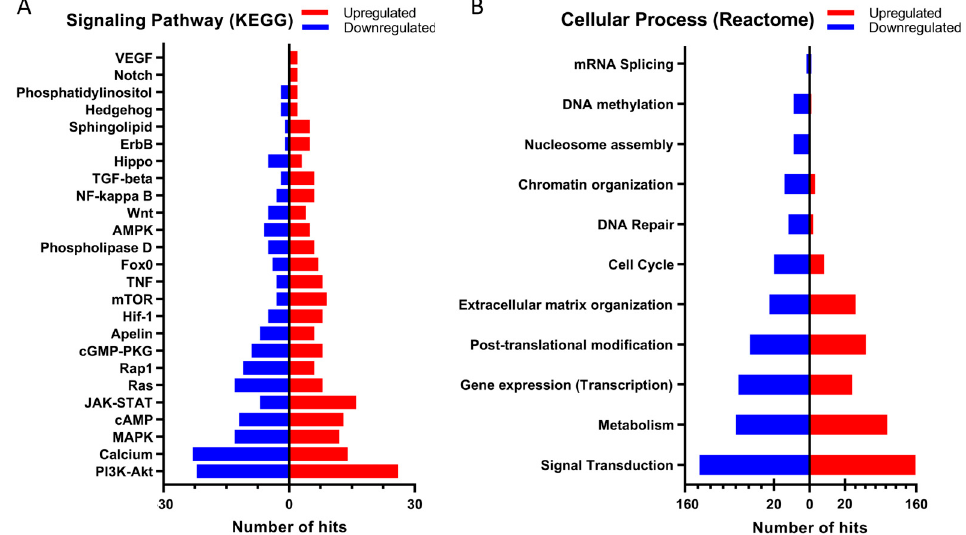
Figure 4. The effect of Tks4 deletion on the signaling pathways ( A ) and cellular processes ( B ). Only genes that showed at least two-fold change in expression (either down- or up-regulation) were considered in the analysis. Upregulation is marked in red, while downregulation is marked in blue. It has to be emphasized that downregulation or upregulation of repressor genes